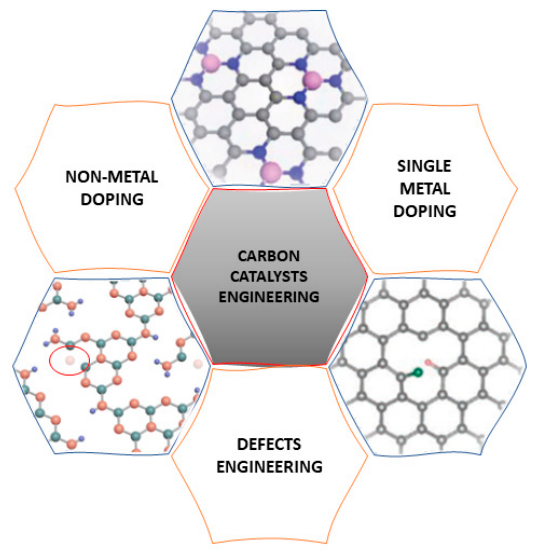
Figure 1. Relevant techniques for carbon catalyst activation and their main combinations.